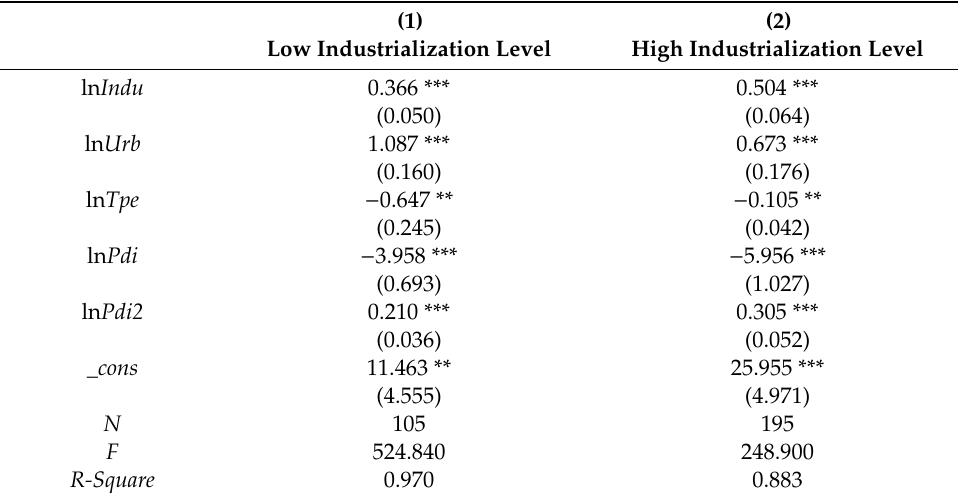
Table 4. Estimation results of samples with di ff erent industrialization levels.